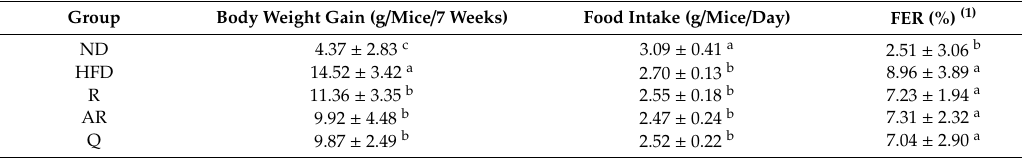
Table 3. E ff ect of experimental diets on body weight gain, food intake, and food e ffi ciency ratio (FER) in mice.